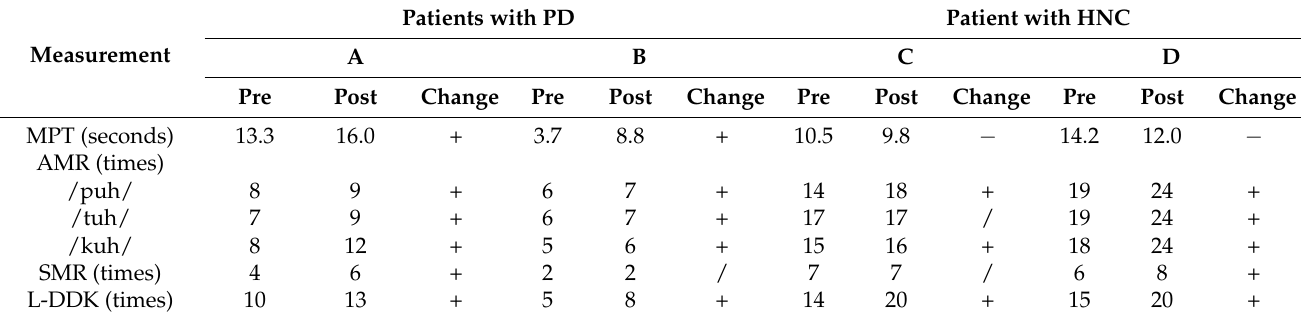
Table 3. Results of vocal and speech-language function measurements. Patients with Measurement